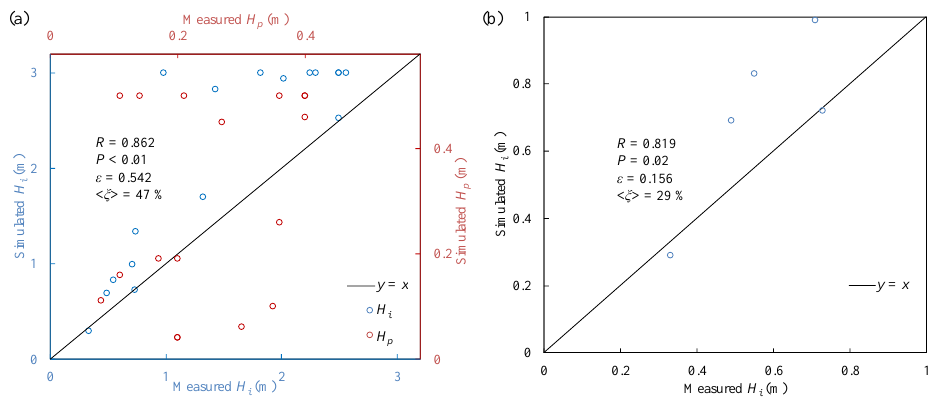
Figure 10. (a) Retrievals of underlying ice thickness and pond depth using measured pond colors in Istomina et al. (2016). Panel (b) is a subset of panel (a) for H i < 1m. R is the correlation coefficient between simulated and measured H i . P is the significance level of the correlation. ε is the root-mean-square error, and <ξ > is the mean of relative error in simulated H i